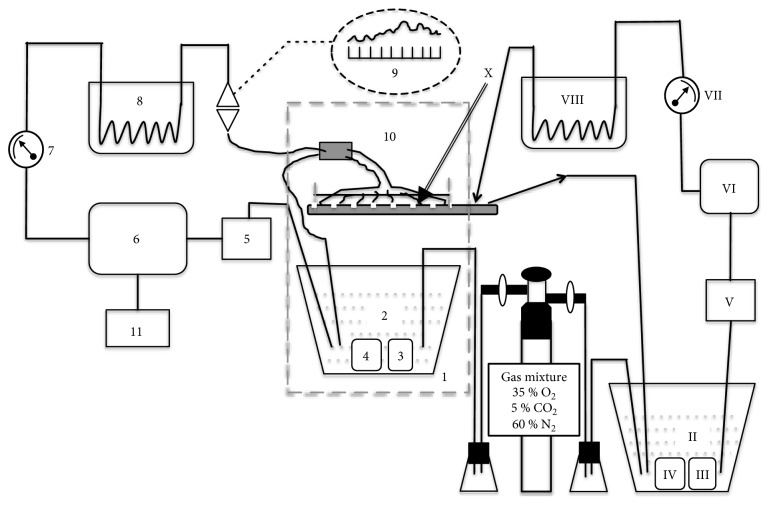
General scheme of in vitro dual placental perfusion system under normoxia. Elements of fetal side (Arabic numeration) and maternal side (Roman numeration) perfusion system: 1, I thermostatic chamber; 2, II reservoir; 3, III oxygen monitor with polarographic (Clark) oxygen electrodes; 4, IV pH meter; 5, V filter; 6, VI peristaltic pump; 7, VII flowmeter; 8, VIII thermostat; 9 Ludwig's manometer with kymograph; 10, X fetal and maternal compartments of perfusion chamber, 11 dosimetric pump.